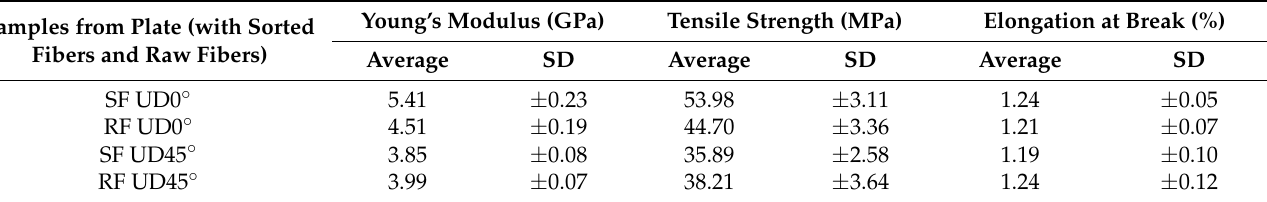
Table 4. Summary of tensile tests (1 mm/min) on unidirectional SF and RF. Samples from Plate (with Sorted Fibers and Raw